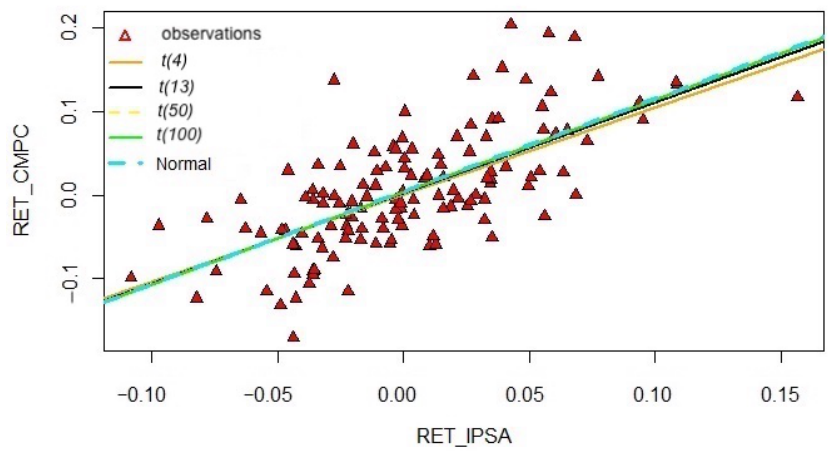
Figure 7. Scatter plot of monthly returns for the IPSA and CMPC with fitted CAPM lines under the Student-t and normal